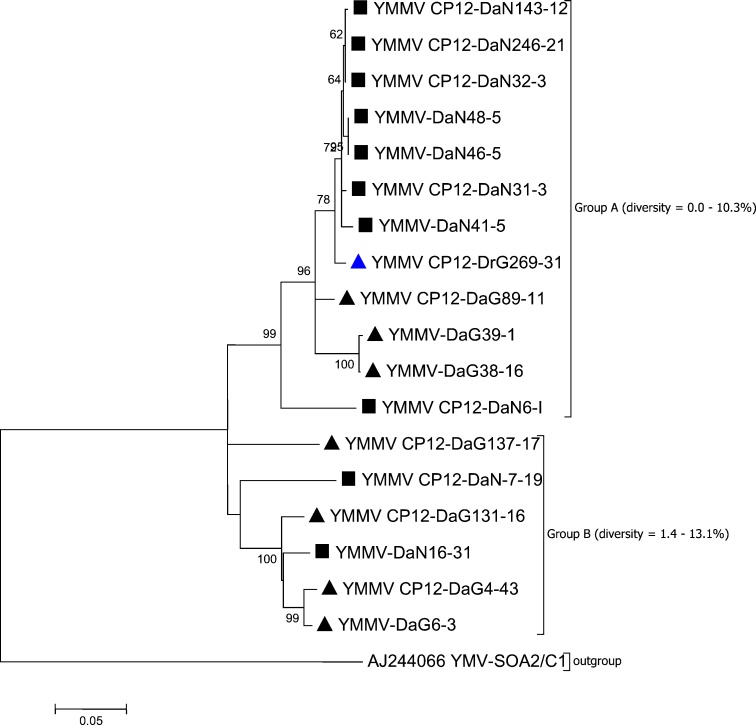
Cladogram based on sequences of the CP region of 18 YMMV isolates collected from D. alata in Nigeria (◼) and Ghana (▲) and from D. rotundata in Ghana (), using neighbour-joining method. The tree was generated using neighbour-joining method in MEGA7 with 1000 bootstrap replications, with branches <60% were collapsed. The scale bar represents the number of nucleotide substitutions per site.